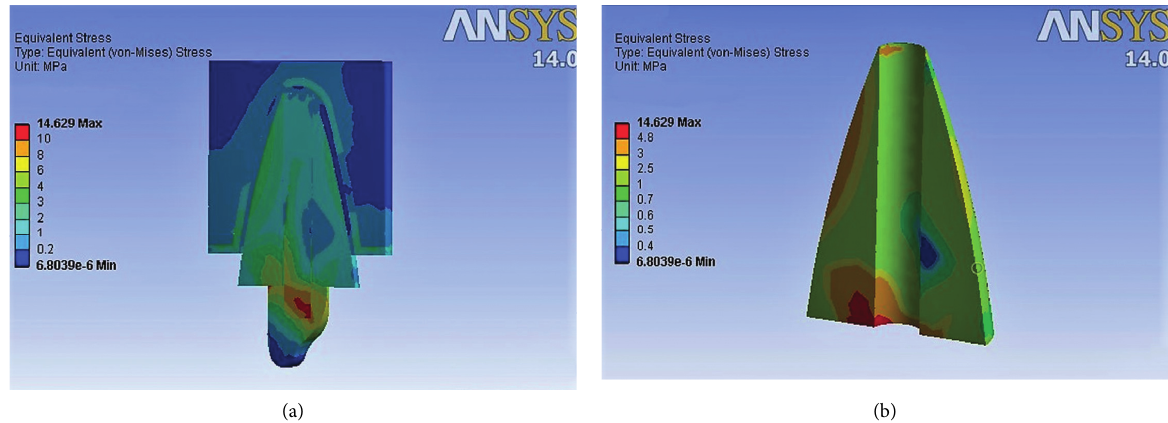
Figure 7: (a) Areas of stress concentration in Model 4 on oblique loading. (b) Areas of stress concentration in Model 4 in root cross